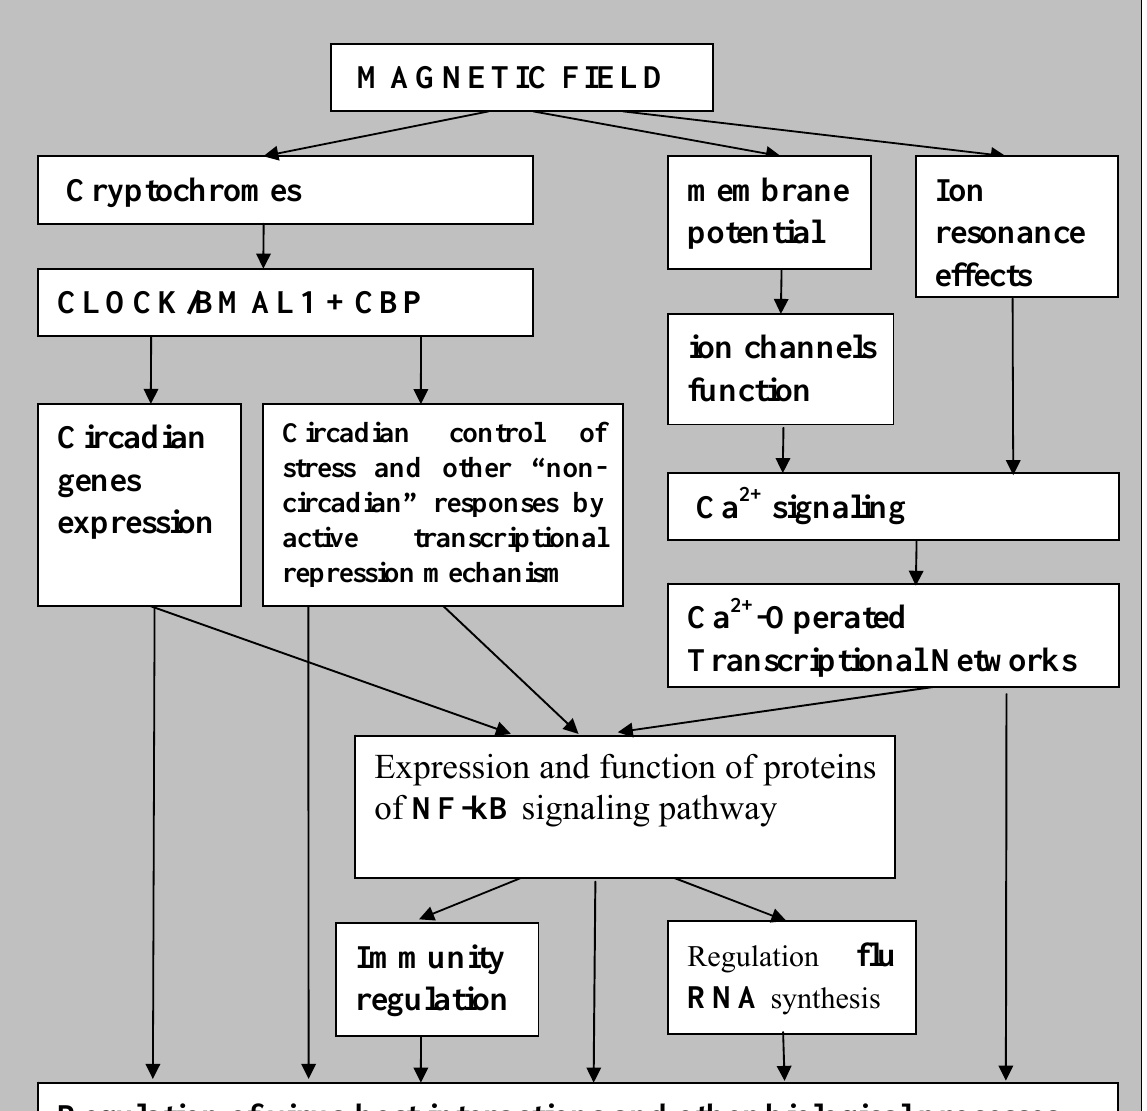
Figure 11. Probable mechanisms of the magnetic field influence on gene expression and virus-host